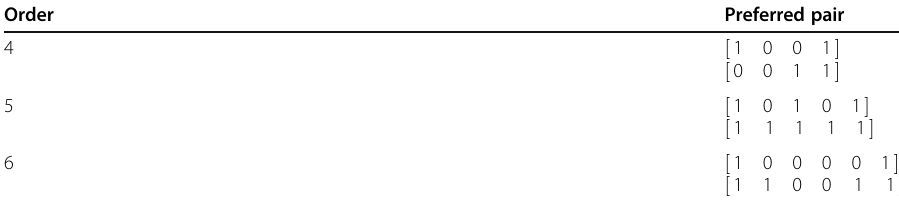
Table 3 Optimal pairs of Gold sequences with different orders. The Gold sequence optimization pairs of different orders selected in the simulation Order Preferred pair